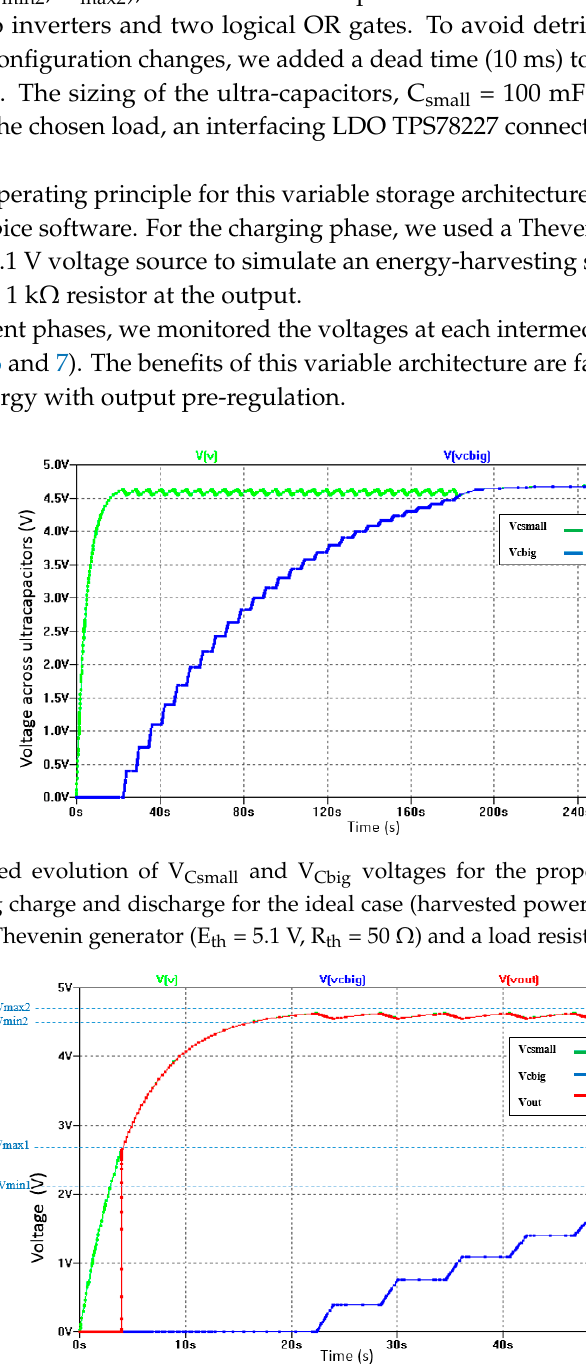
Figure 7. Zoomed view of Figure 6 showing details of the startup phase and the evolution of V out .